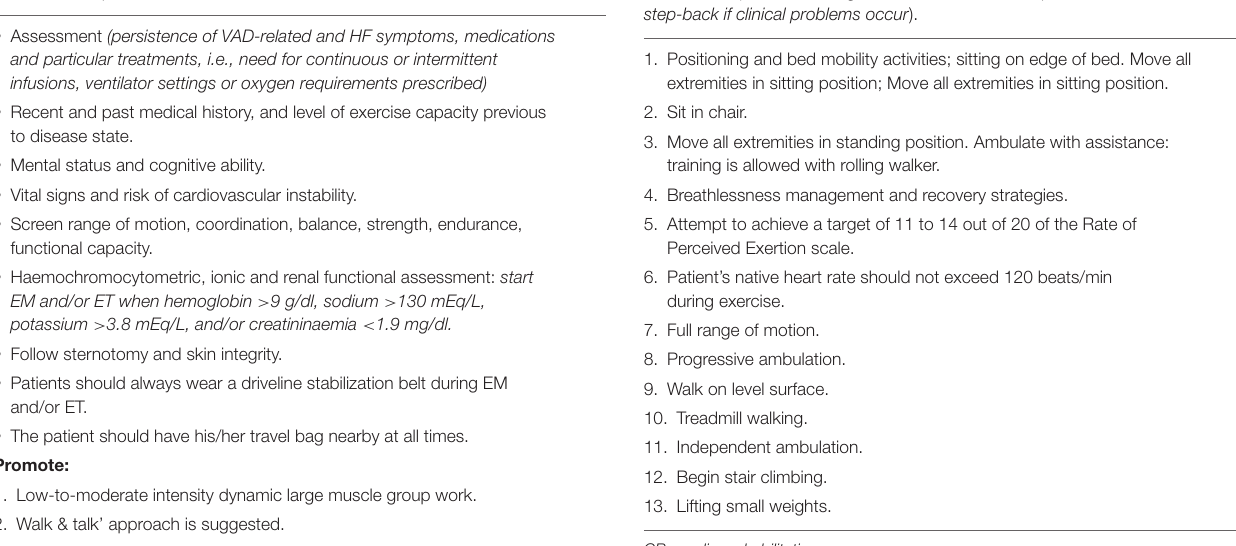
TABLE 2 | Instruction to reduce the risk of adverse events when early mobilization starts in LVAD patients.